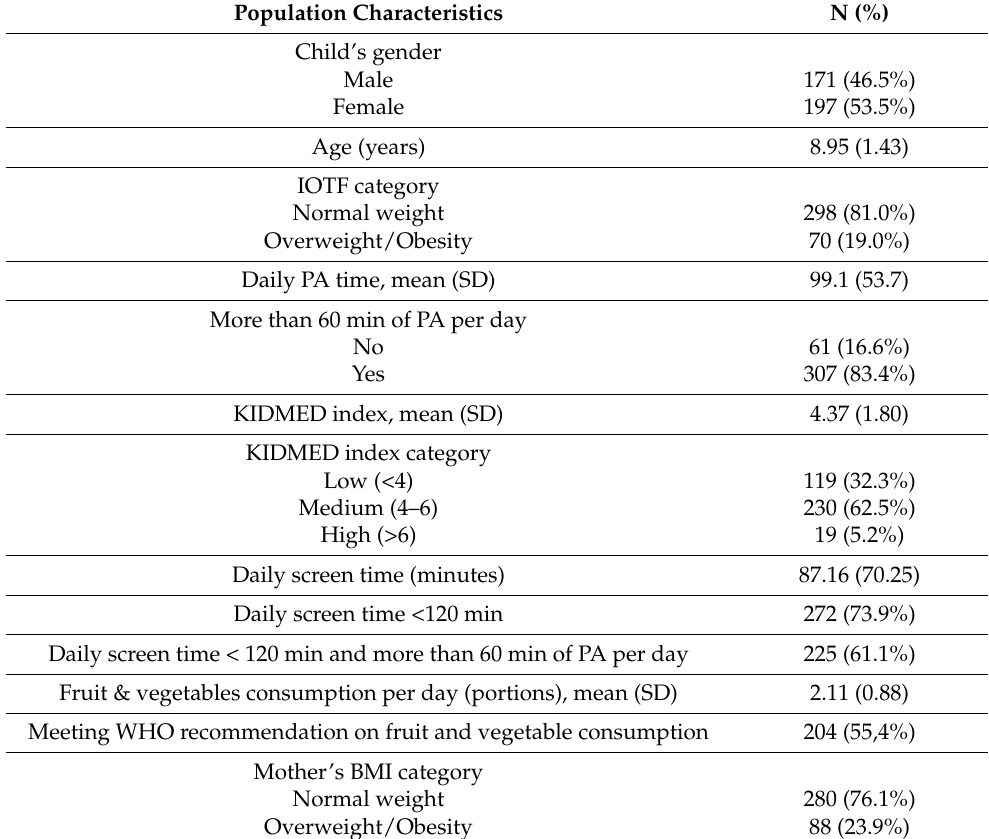
Table 1. Population characteristics (N =